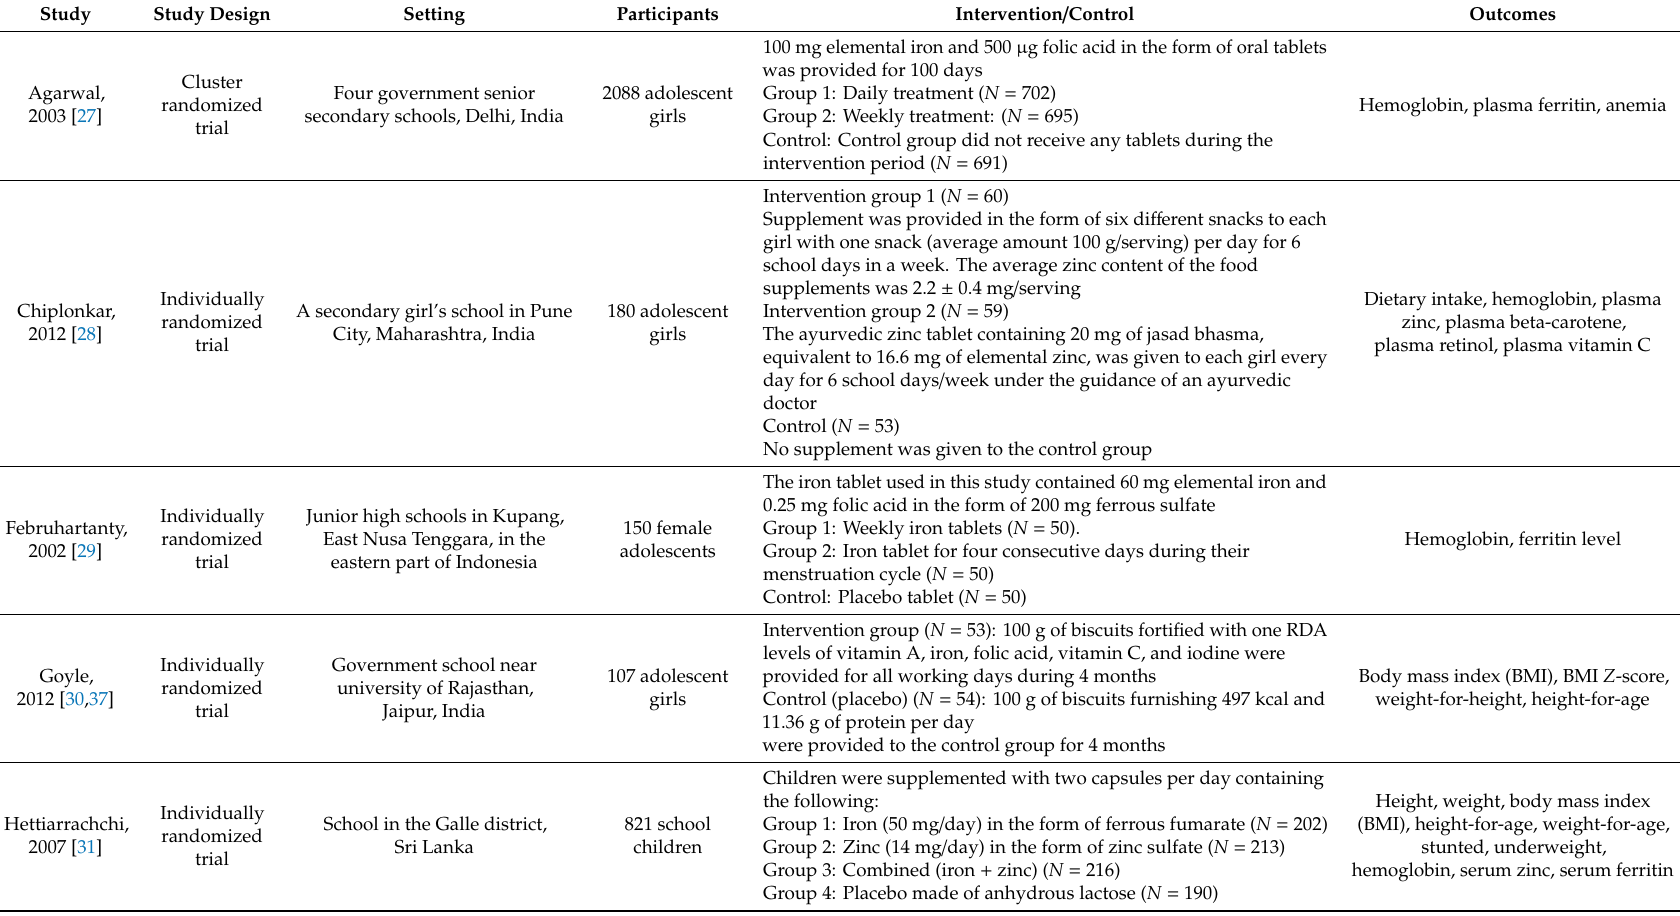
Table 1. Characteristics of the included